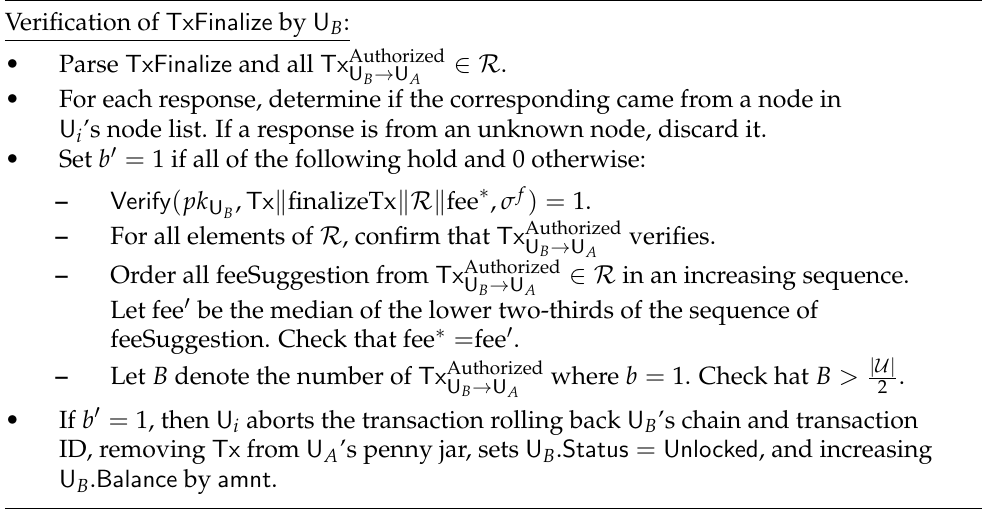
Figure A3. The verification of TxFinalize by nodes in Dandelion.